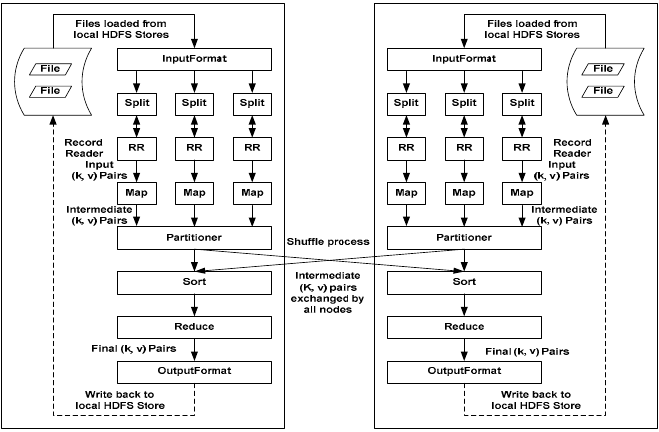
Figure 5. Actual operation diagram of MapReduce.